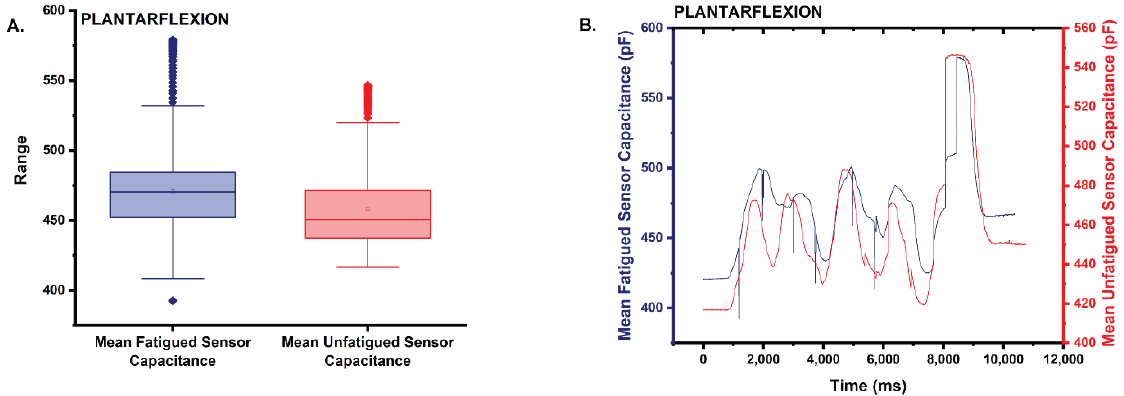
Figure 9. ( A ) Box plot of the statistics comparing the mean capacitance of the fatigued sensor to that of the unfatigued sensor in plantarflexion. Note that the mean capacitance is higher for the fatigued sensor. ( B ) Plot comparing the mean capacitance of the fatigued sensor to the unfatigued sensor during the plantarflexion trials.